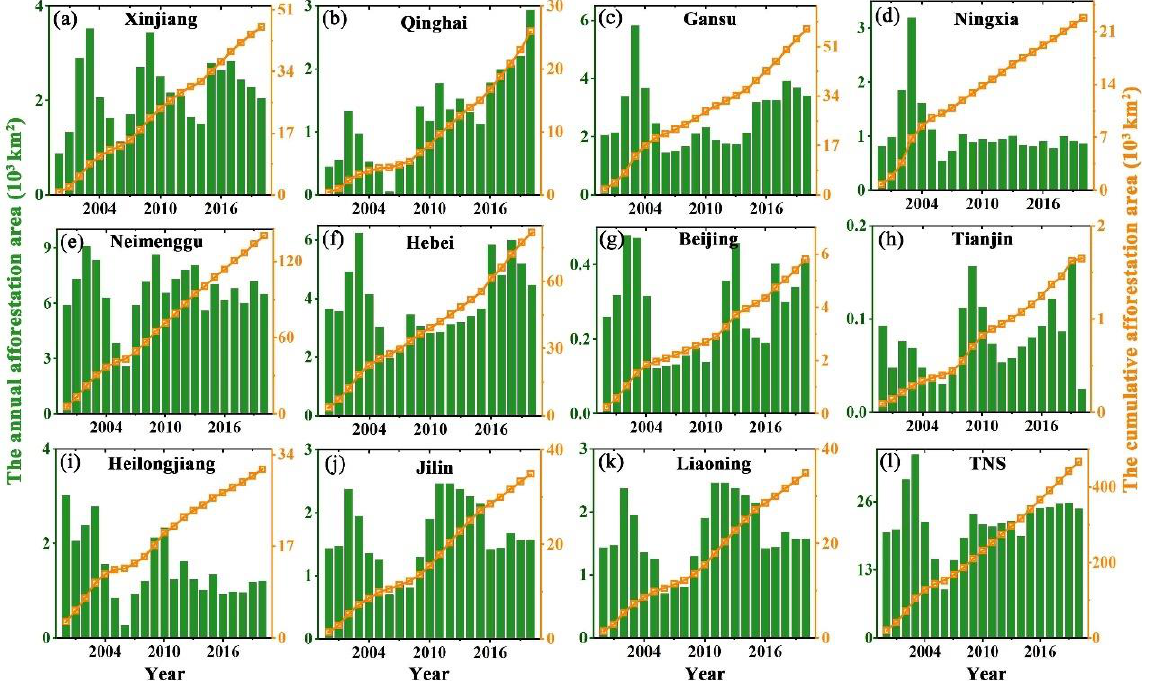
Figure 14. Statistics of plantation area and cumulative plantation area of the TNS ( l ) and each province ( a – k ) from 2000 to 2020.